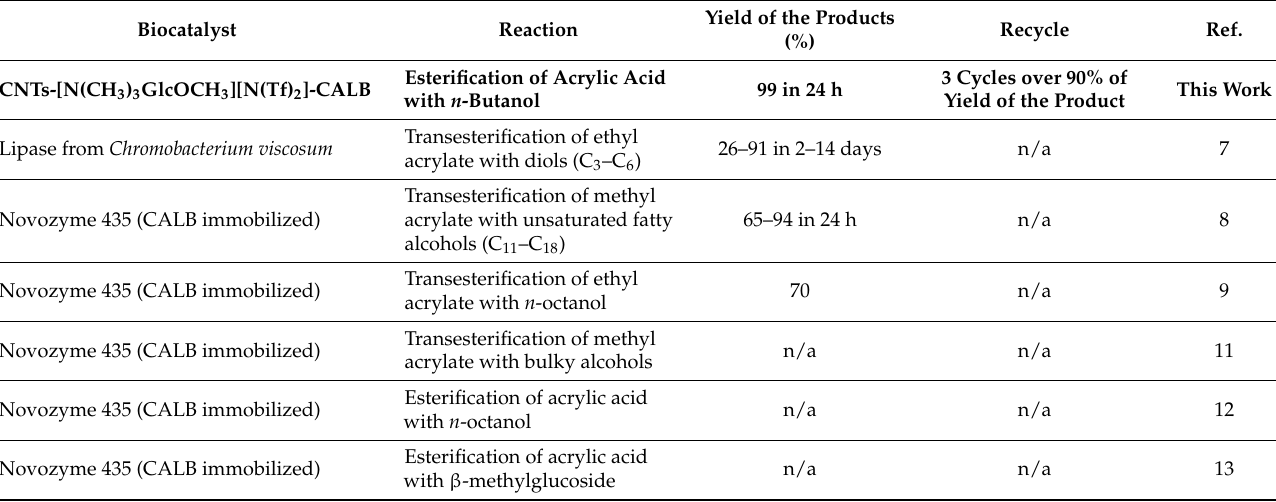
Table 4. The influence of the selected parameters on the yield of n -butyl acrylate. Biocatalyst